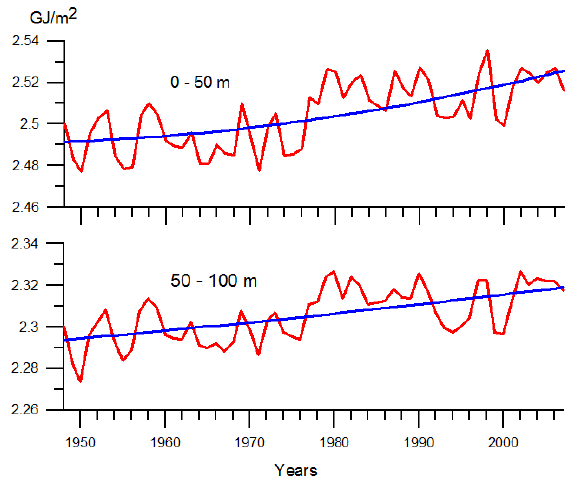
Figure 2. Time series of the WO heat content and its quadratic trend for the period of 1948–2007 in the upper mixed layer: 0–50 and 50–100 m.